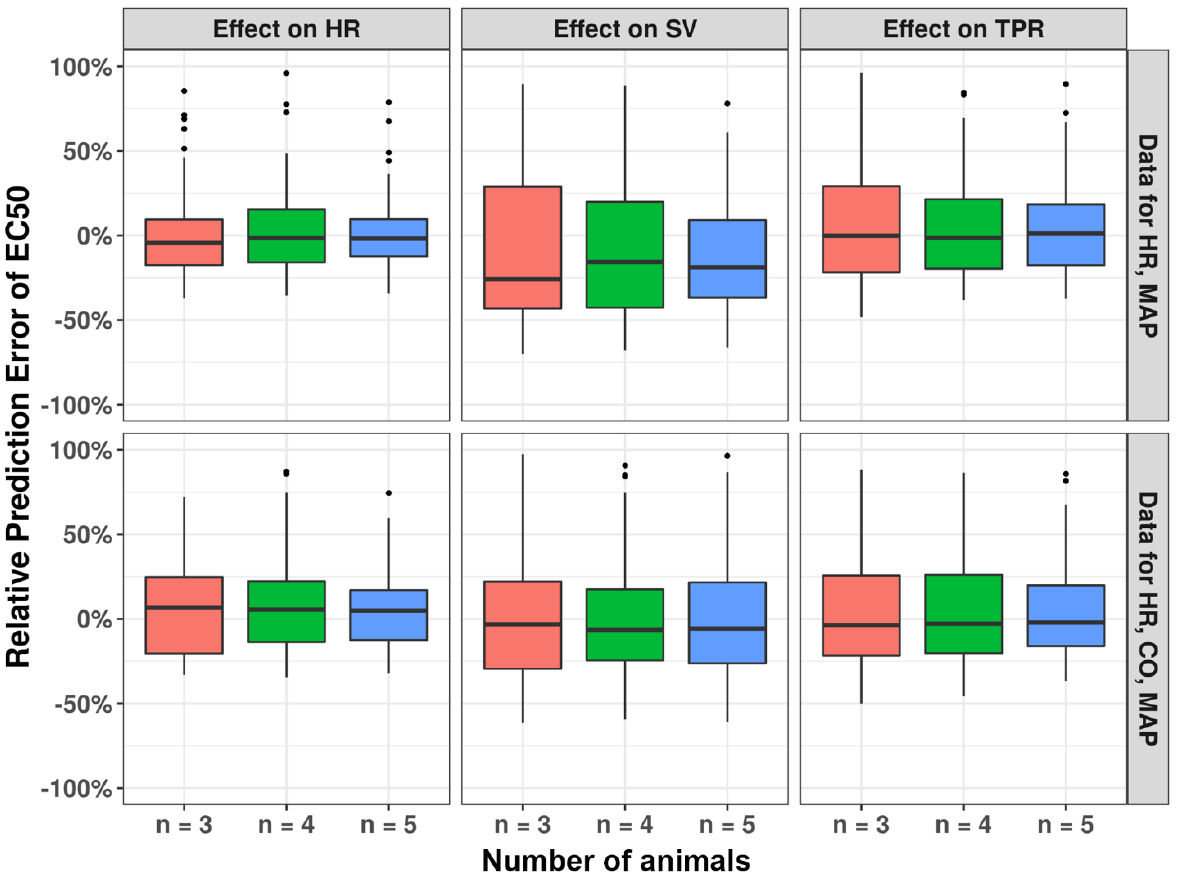
Figure 8. Impact of number of animals used in experiments on relative prediction error of drug effect estimate EC 50 . Derived using SSE analyses using data for 3, 4, or 5 animals with observations of HR and MAP or observations of HR, CO, and MAP, while Emax was fixed as −1 and EC 50 was fixed as 100 ug/mL in the original model.